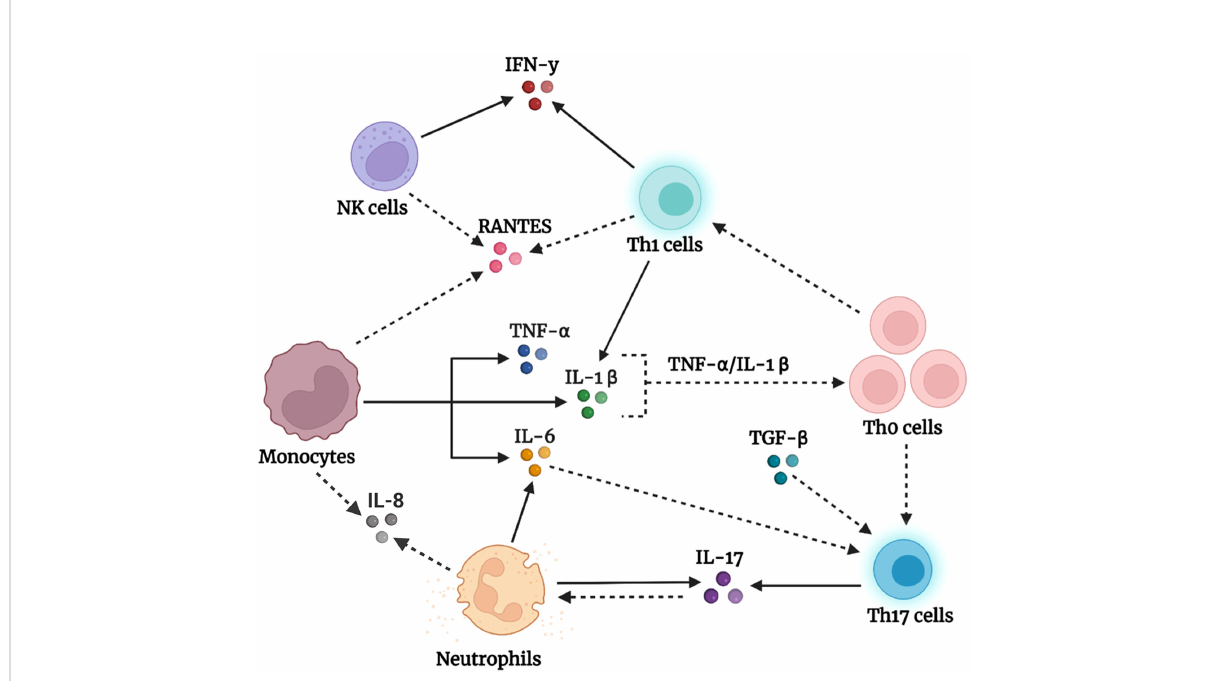
FIGURE 2 Schematic representation of our proposed model of peripheral immune dysregulation in autism.Activated monocytes produce high amounts of the triad of proin fl ammatory cytokines, TNF- a , IL-1 b , and IL-6. Accordingly, TNF- a and IL-1 b promote the activation, priming, and proliferation of naïve and effector T cells, whereas IL-6, in the presence of dysregulated levels of TGF- b , drives the polarization of naïve T helper (Th0) cells into effector Th17 subsets. The latter produces its signature cytokine IL-17, which initiates several events that result in neutrophil recruitment and activation (80). Neutrophils in individuals with autism produce IL-17 and IL-6, which add to the observed large pool of IL-17 and IL-6. In addition, naïve T helper (Th0) cells under the in fl uence of cytokines in the milieu differentiate into Th1 cells, which impart high IFN- g levels and enrich the IL-1 b pool. Natural killer (NK) cells, on the other hand, tend to be dysfunctional in autism and chronically produce IFN- g , which augments the IFN- g pool. Furthermore, the high levels of the chemotactic factor RANTES might be derived from activated monocytes, T cells, or NK cells, whereas IL-8 might be produced by monocytes and neutrophils, and function to recruit cells to the scene. The solid arrows represent con fi rmed fi ndings in the tables we formulated, whereas the dashed arrows are based on well-known facts in the literature that we suggest occur in the context of autism. Created using